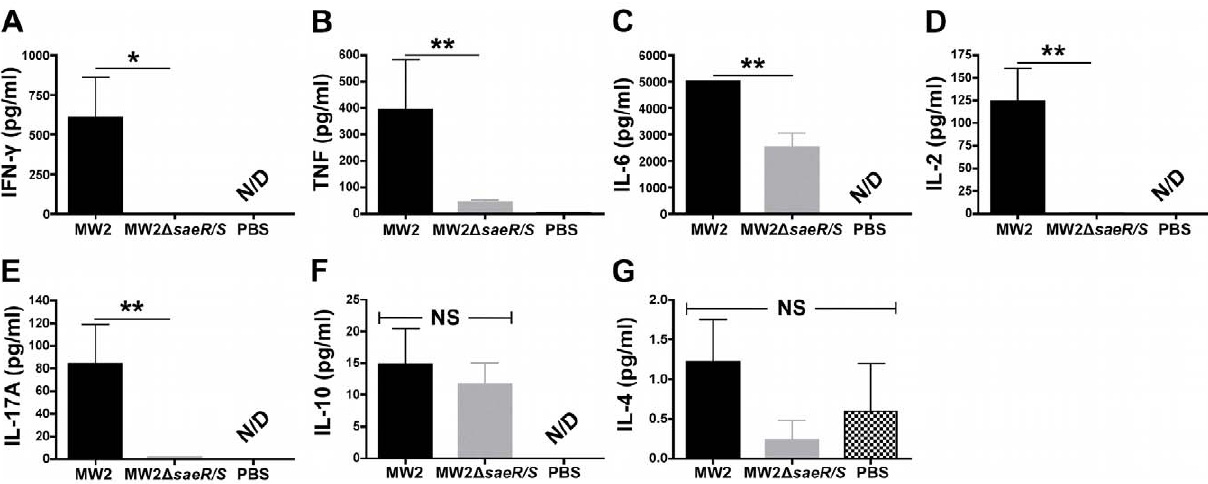
Figure 2. SaeR/S elicits systemic pro-inflammatory cytokines during invasive S.aureus infection. Mice were inoculated i.p. with MW2, MW2 D saeR/S (5 6 10 7 cfu) or PBS for 10 hours and serum cytokine concentrations were measured by cytometric bead array. Serum concentrations (pg/ml) of ( A ) IFN- c , ( B ) TNF, ( C ) IL-6, ( D ) IL-2, ( E ) IL-17A, ( F ) IL-10 and ( G ) IL-4. Results displayed are from 5 mice (MW2), 7 mice (MW2 D saeR/S ) and 2 mice (PBS). * P , 0.05 and ** P , 0.01 compared to cytokine expression in MW2-infected mice for each cytokine investigated as determined by t test. NS=not significant; N/D=not detectable.